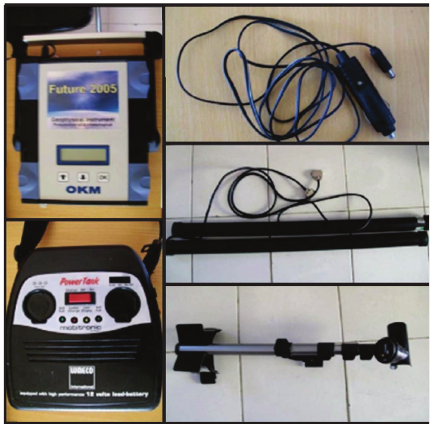
Figure 3: GPR Future 2005